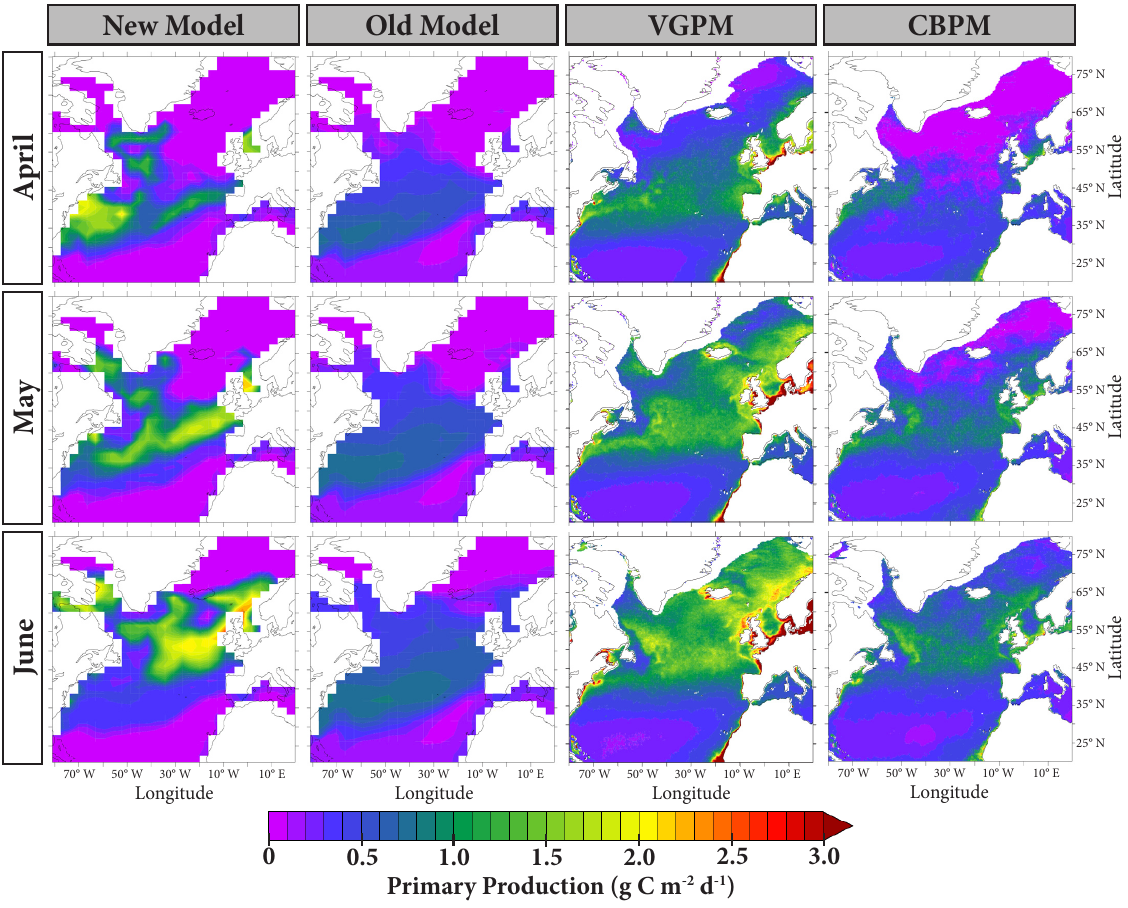
Fig. 19. Spring-time primary production comparisons in the North Atlantic between the new and old model simulations and estimates from Behrenfeld and Falkowski’s (1997) vertically generalised production model (VGPM) and Westberry et al.’s (2008) carbon-based productivity model (CbPM). Table 4. Comparison of critical properties that drive the global biological